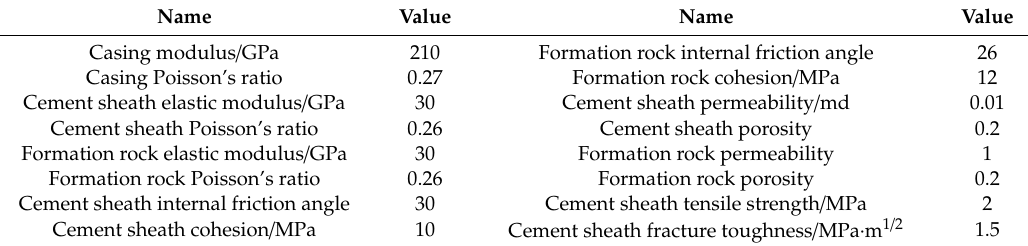
Table 2. Material parameters of each parts in the models.